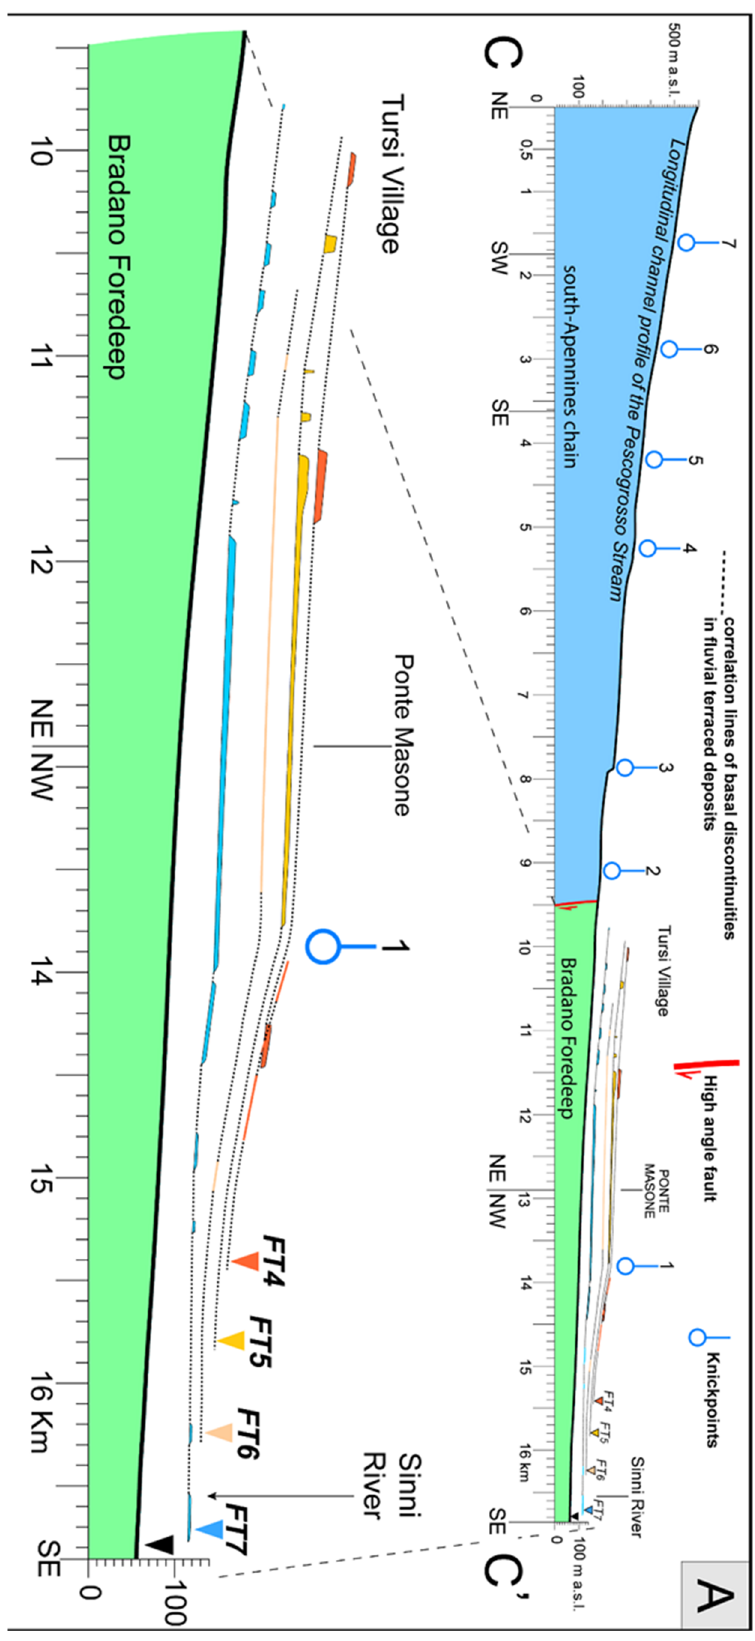
Figure 11. Plot of the longitudinal terrace profiles against the present-day Pescogrosso channel profile. See text for explanations and Figure 3 for profile location.